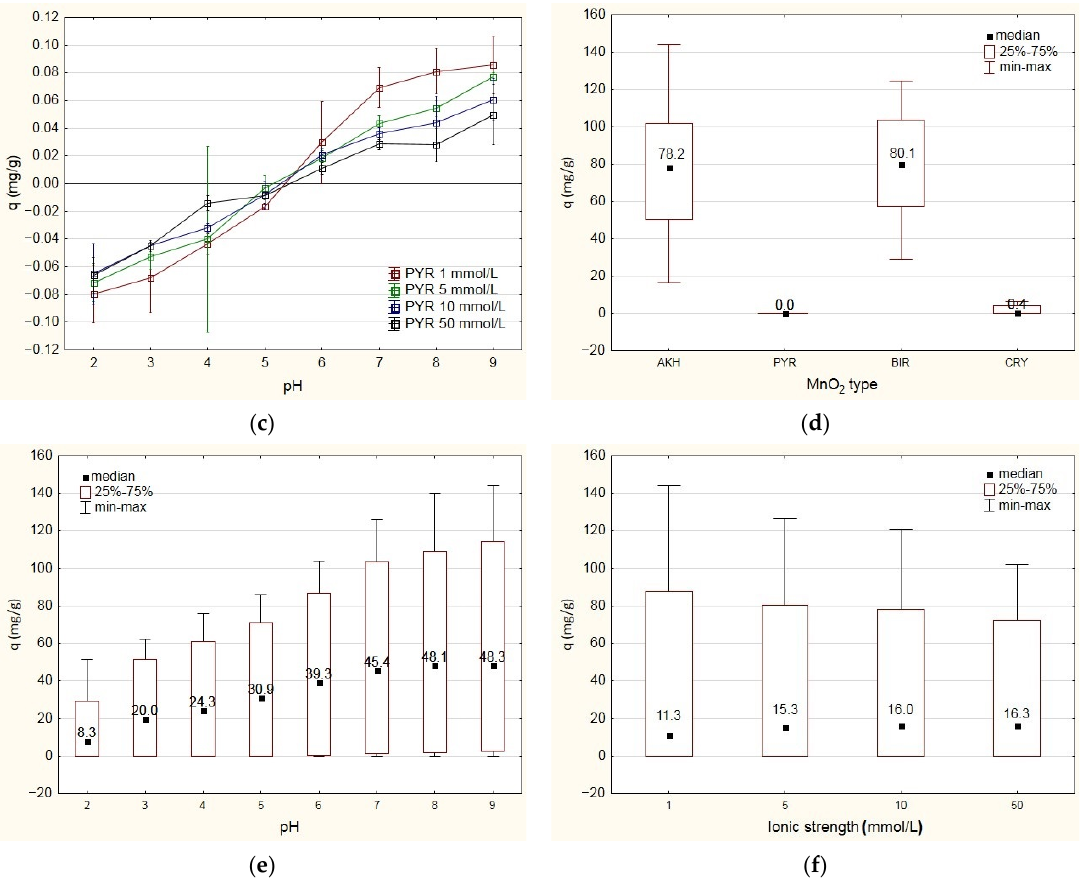
Figure 1. Mn adsorption capacity in different conditions of pH and ionic strength for the following: ( a ) akhtenskite (AKH) and birnessite (BIR); ( b ) cryptomelane (CRY); ( c ) pyrolusite (PYR). The ANOVA results for: ( d ) manganese dioxide (MnO 2 ) polymorph type; ( e ) pH of water solution; ( f ) ionic strength of water solution.